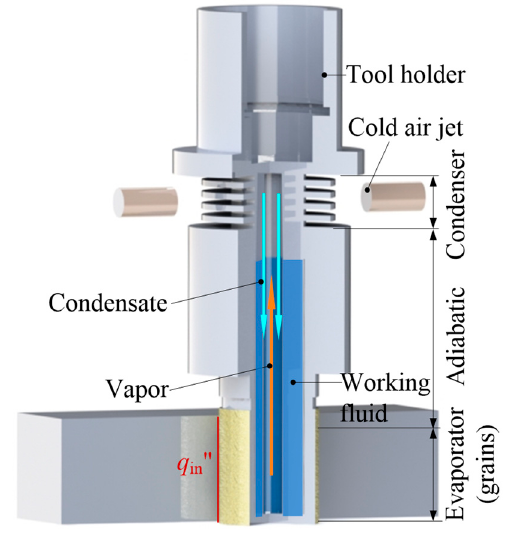
Figure 1. Schematic of RHP-GW.